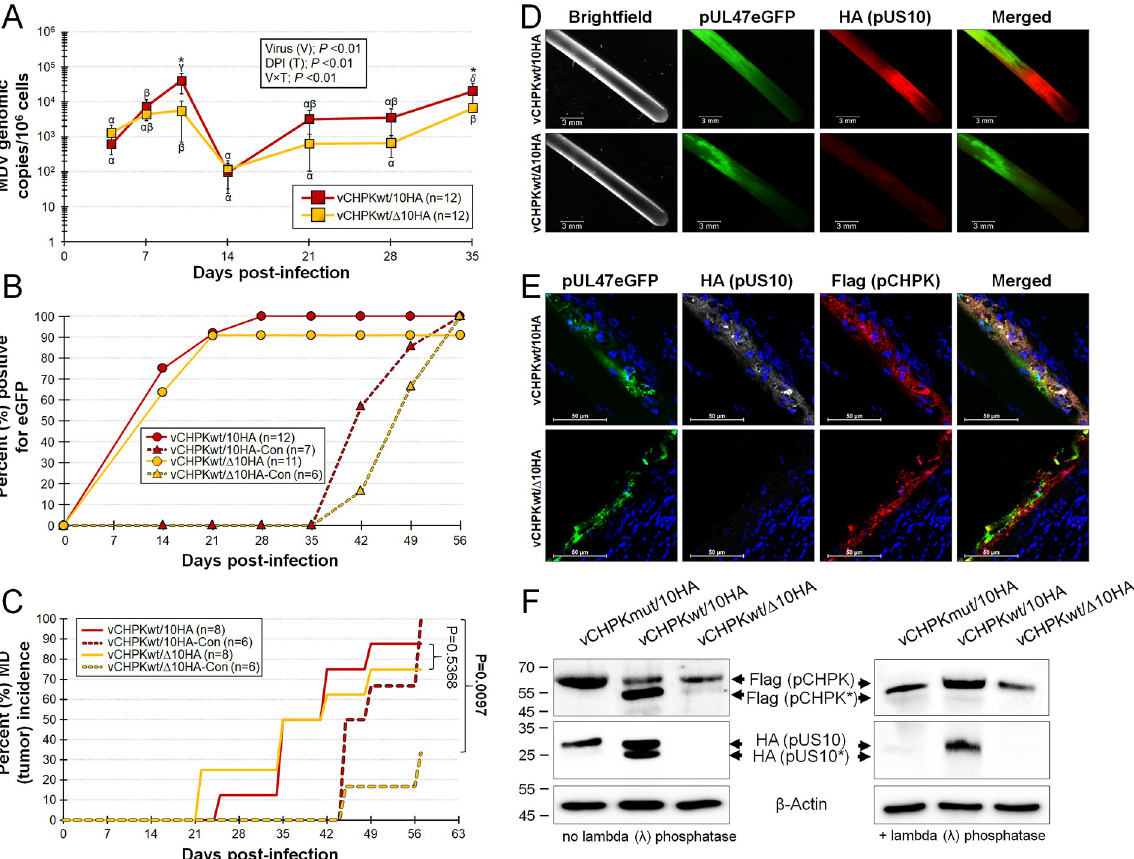
Fig 9. Replication, MD induction, and horizontal transmission of pUS10-null rMDV. PC chickens were infected with vCHPKwt/10HA or vCHPKwt/ Δ 10HA as described in the Materials & Methods. (A) Mean MDV genomic copies/10 6 blood cells ± standard error of means was determined in experimentally infected chickens using qPCR assays. Significant differences were determined for both virus (V) and time (T) and their interactions (V × T). Significant differences between the two groups were determined at 10- and 35-days pi ( � , p < 0.05). Values with Greek letters are significantly different within each group at other time points (p < 0.05, two-way ANOVA, Tukey’s, n = 252). (B) FFs were plucked from experimentally and naturally infected groups and the percent of birds with FF positive for MDV based on pUL47eGFP expression was determined. There were no significant differences between the two groups in experimentally- ( P = 0.48) and naturally- ( P = 1.00) infected chickens using Fisher’s exact tests. (C) Total MD incidence was determined for each group. There were no significant differences in the total number of chickens developing MD in experimentally infected chickens, while chickens naturally infected were significantly different by day 57 dpi using Fisher’s Exact Tests. (D) Feathers were plucked from experimentally infected chickens at 35 days pi and stained for pUS10 with the anti-HA antibody. Scale bars are 3 mm. (E) Feather/skin tissue cryosections cut transversely through the FFs from vCHPKwt/10HA and vCHPKwt/ Δ 10HA-infected chickens at 35 days pi. Sections were fixed and stained with anti-Flag (pCHPK) and -HA (pUS10) antibodies. Also shown is pUL47eGFP (green) and Hoechst 33342 staining for DNA (blue). Shown are representative images of four different FFs for each virus and antigen staining. Scale bars are 50 μ m. (F) Immunoblotting under reducing conditions of total protein collected from infected FFE cells scraped from FFs. Proteins were collected from vCHPKwt/10HA and vCHPKwt/ Δ 10HA from the current experiment and vCHPKmut/10HA from a separate bird experiment. Anti-Flag, -HA, and β -Actin Mabs were used to identify pCHPK, pUS10, and β -Actin (protein loading control), respectively. Phosphorylated pCHPK was formerly shown to be the lower band [23] and denoted as pCHPK � , while predicted phosphorylated US10 is also denoted as